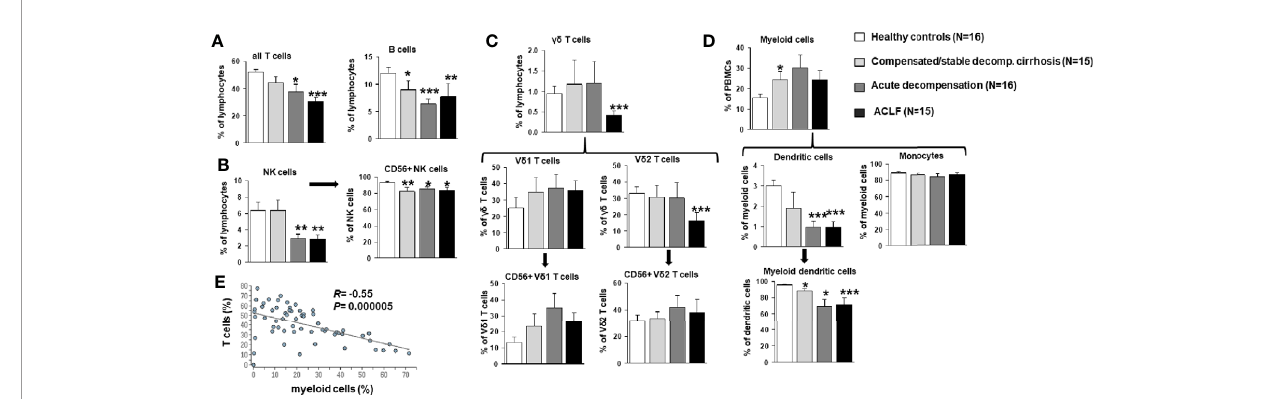
FIGURE 2 | Frequencies of T cells, B cells, NK cells, gd T cell, and myeloid cells in patients with progressive stages of liver cirrhosis liver cirrhosis vs. healthy controls. (A) T and B cell frequencies are represented as frequency of all living lymphocytes. (B) NK cells (CD33 positive and CD16 positive) were further classi fi ed according to CD56 expression as a marker for cytotoxicity. (C) gd T cells (CD3 positive and gd TCR positive) were stained for V d 1, V d 2 and CD56 to identify major subpopulations. (D) Dendritic cells were identi fi ed as being CD14 negative and MHCII positive and classi fi ed as myeloid dendritic cells if CD11c positive. Cell frequencies are represented as frequency of all living cells for myeloid cells and as frequency of the parent population for all subtypes. (E) Correlation between frequencies of T cells and myeloid cells. * P <0.05, ** P <0.01, *** P <0.001.